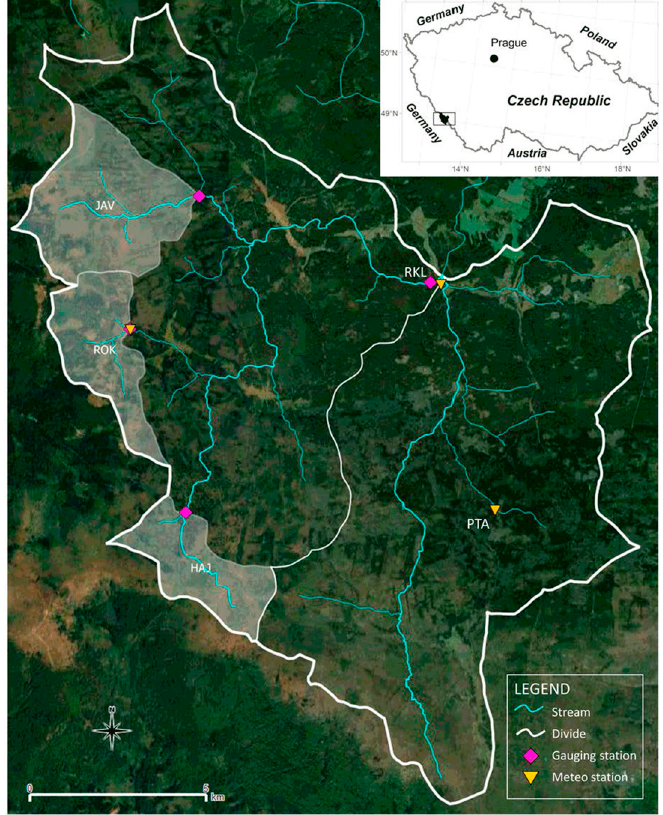
Figure 1. Study area. Upper Vydra basin with experimental catchments and automated sensor network stations.